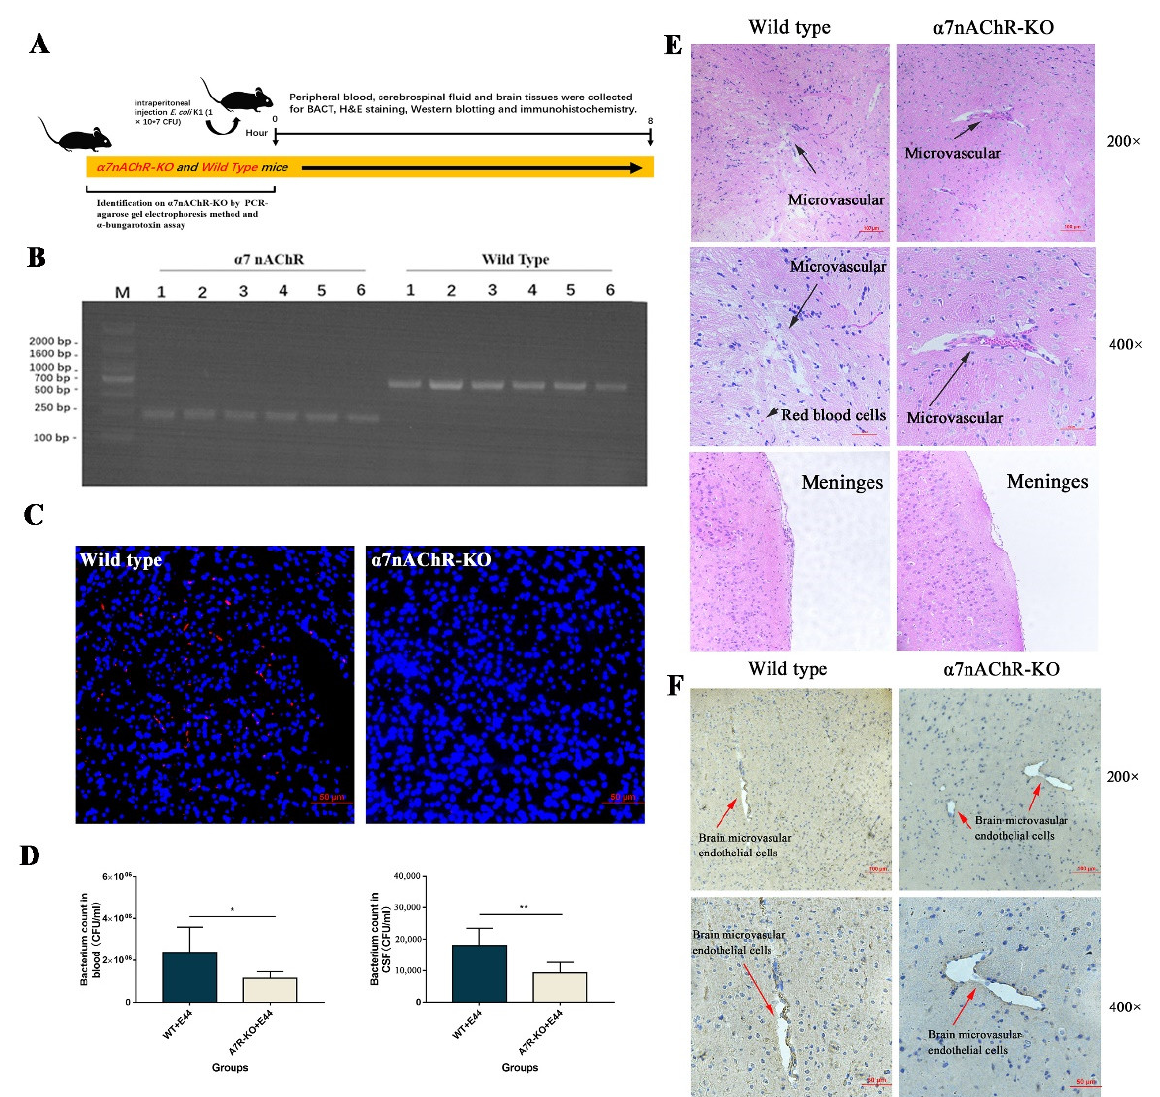
Figure 2. E. coli E44 induced BBB injuries in α7nAChR-KO and wild-type mice in vivo. ( A ) Experi- ment design in vivo. ( B ) Genotype of F2 generation α7nAChR knockout mice by PCR. ( C ) Fluores- cence staining of α-Bungarotoxin in brain tissue collected from wild-type and α7nAChR-KO mice, conducted by Axio Imager M2 software (Nikon, JPN). ( D ) Bacterial load in blood and cerebrospinal fluid of WT/α7nAChR-KO mice infected with E. coli E44. ( E ) Morphological observations of brain microvascular and meninges in wild-type and α7nAChR-KO mice by H&E staining. ( F ) Morpho- logical observations of brain microvascular in wild-type and α7nAChR-KO mice by JAK2 immuno- histochemistry technique. * p < 0.05, ** p < 0.01.